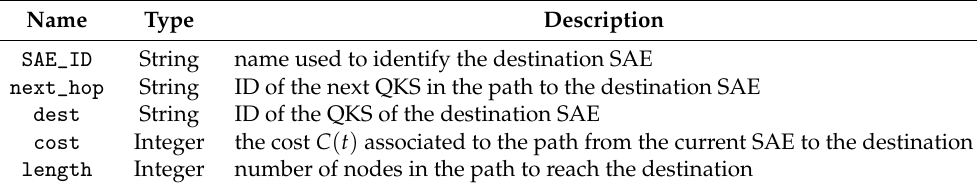
Table 1. Description of the routing table entries in